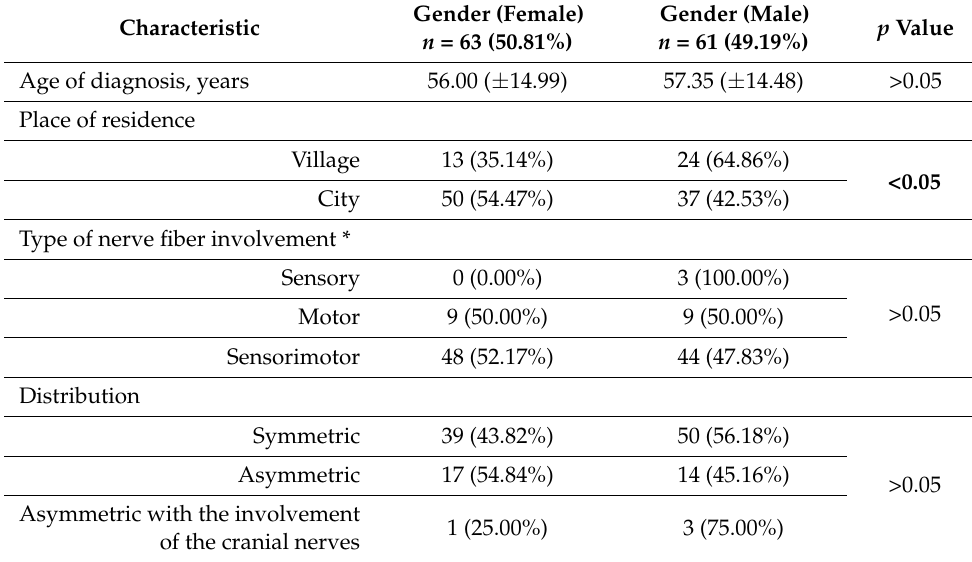
Table 1. Summary of demographic and clinical